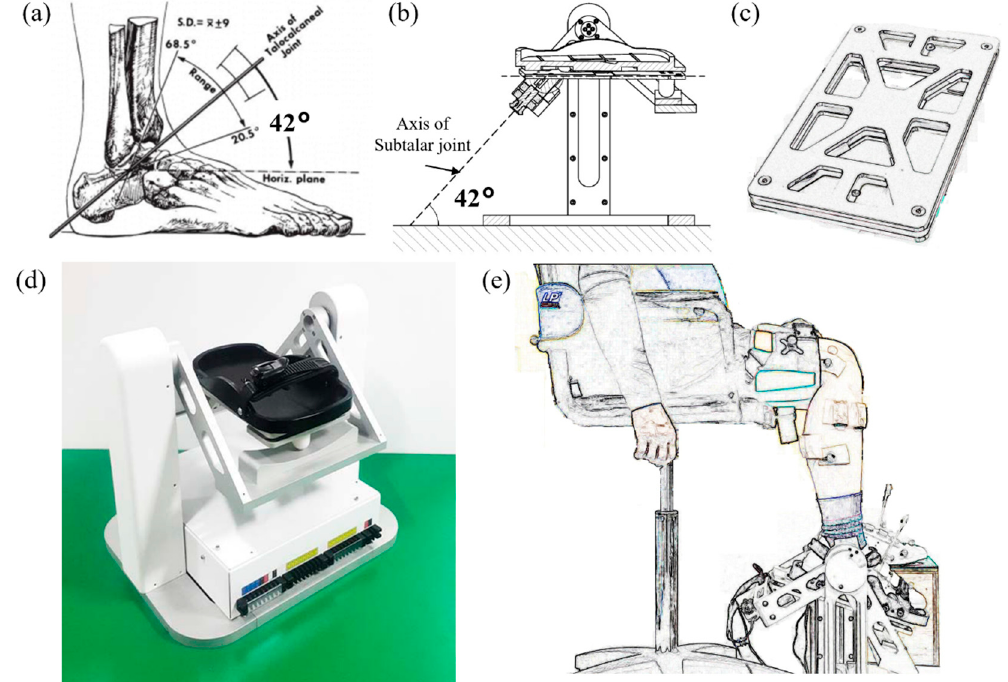
Figure 1. Ankle movement trainer (AMT): ( a ) Ankle anatomical characteristics (42°) in the sagittal plane of the subtalar axis [9]; ( b ) AMT mechanical design of subtalar axis; ( c ) AMT force plate with four load cells at four corners; ( d ) Ankle movement trainer (AMT); ( e ) Experimental layout of AMT human subject trial (AMT dorsi-/plantar flexion).